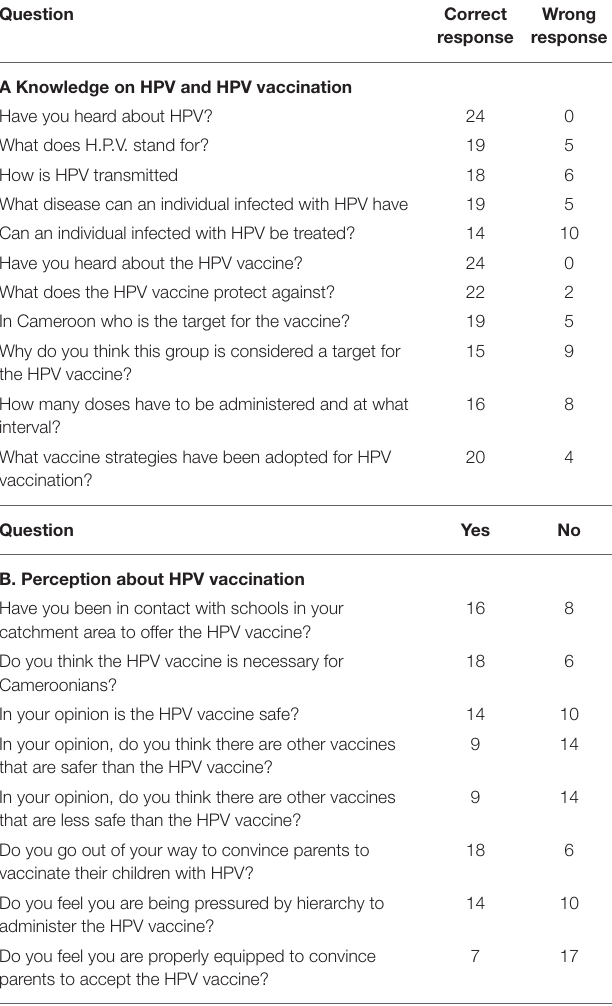
TABLE 2 | Vaccinators’ responses to questions on HPV knowledge and perception ( n =